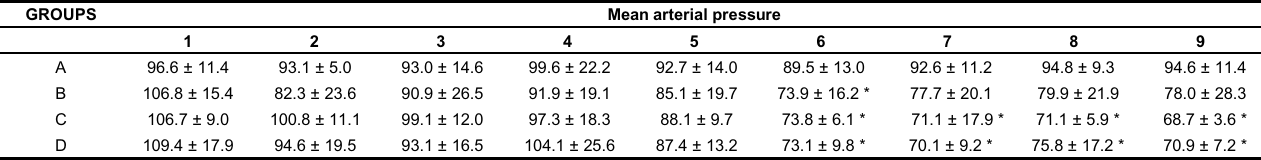
TABLE 1 – Mean arterial pressure (mmHg) in animals during the surgical